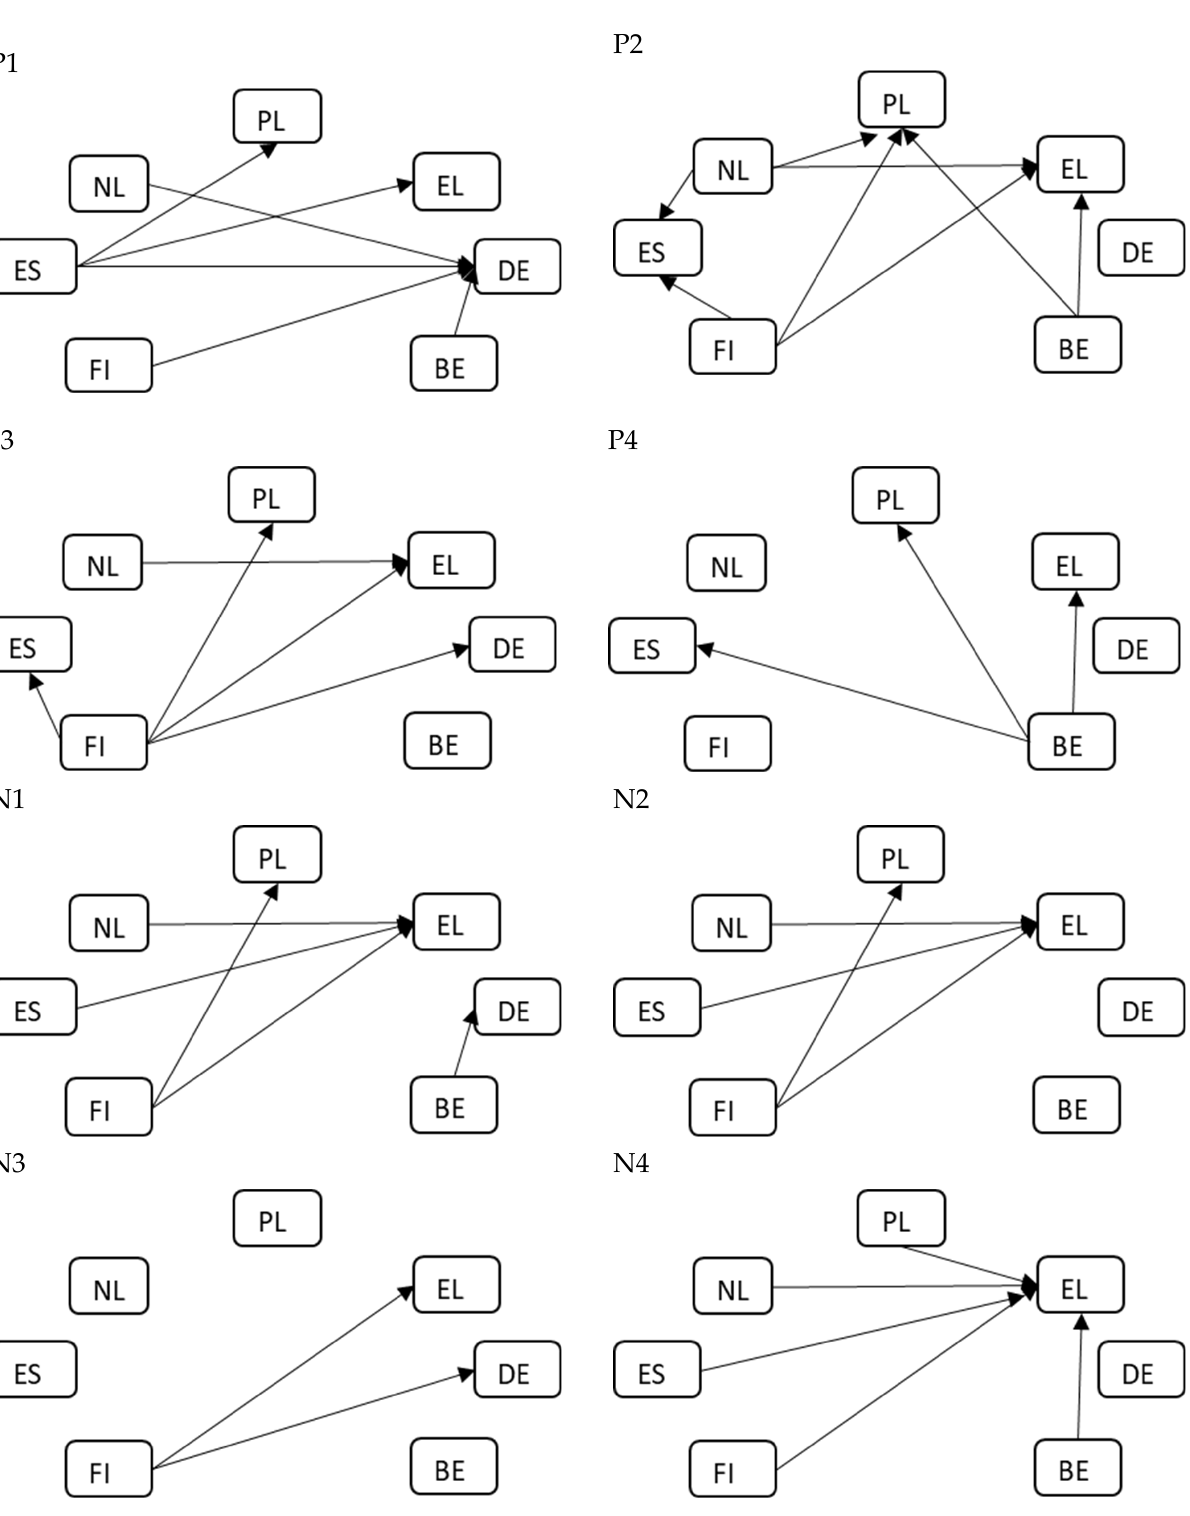
Figure 2. Visualization of significant differences in the answers to statements P1–P4 and N1–N4 given by the respondents from different countries based on the post hoc tests.